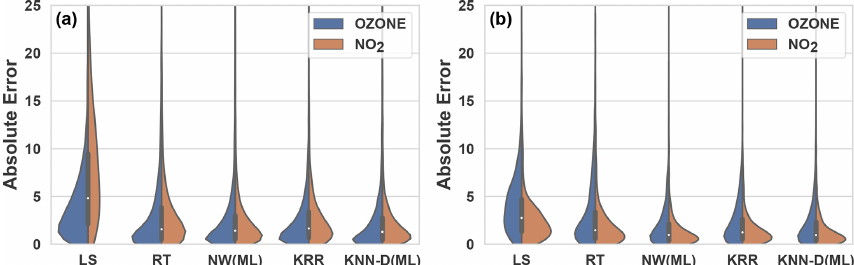
Figure 5. The violin plots on the left (a) show the distribution of absolute errors incurred by various models on the DD1(October) (MM5(June)) datasets. KNN-D(ML) offers visibly superior performance as compared to other algorithms such as LS and RT.